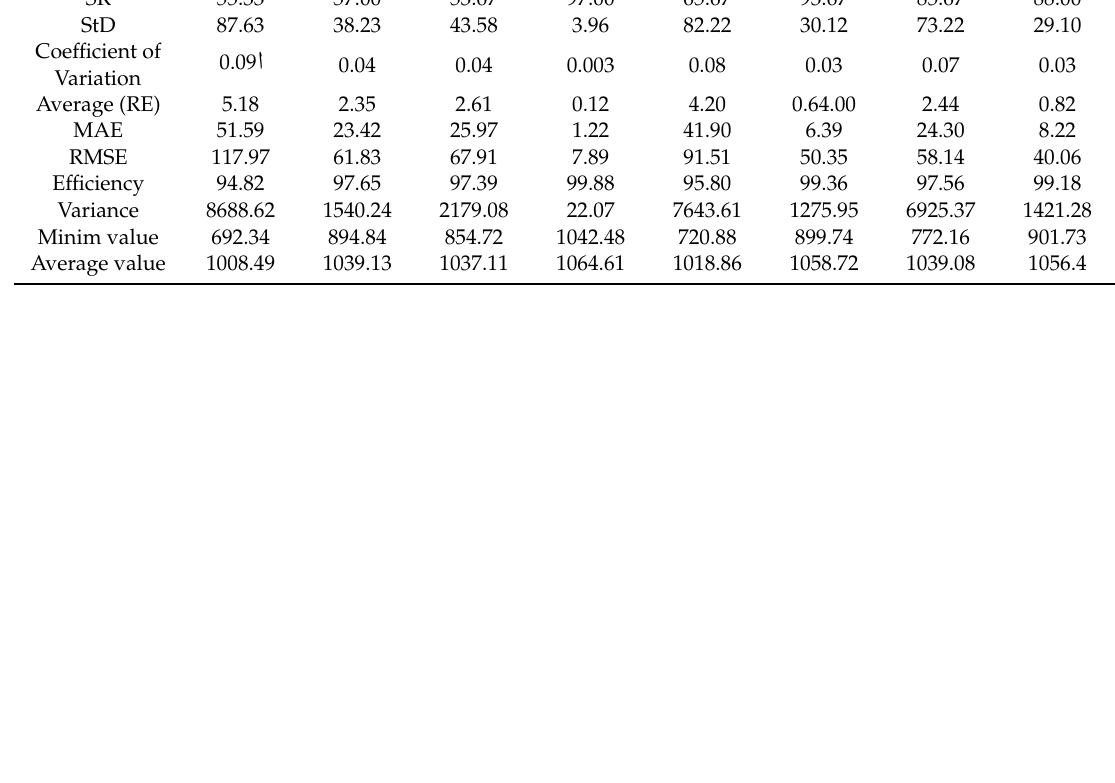
Table 4. A comparison among considered